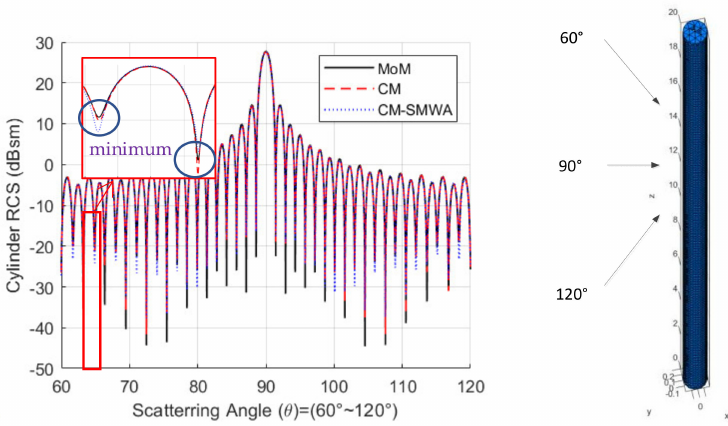
Figure 9. Comparison of the RCS simulations of cylinders with different methods.